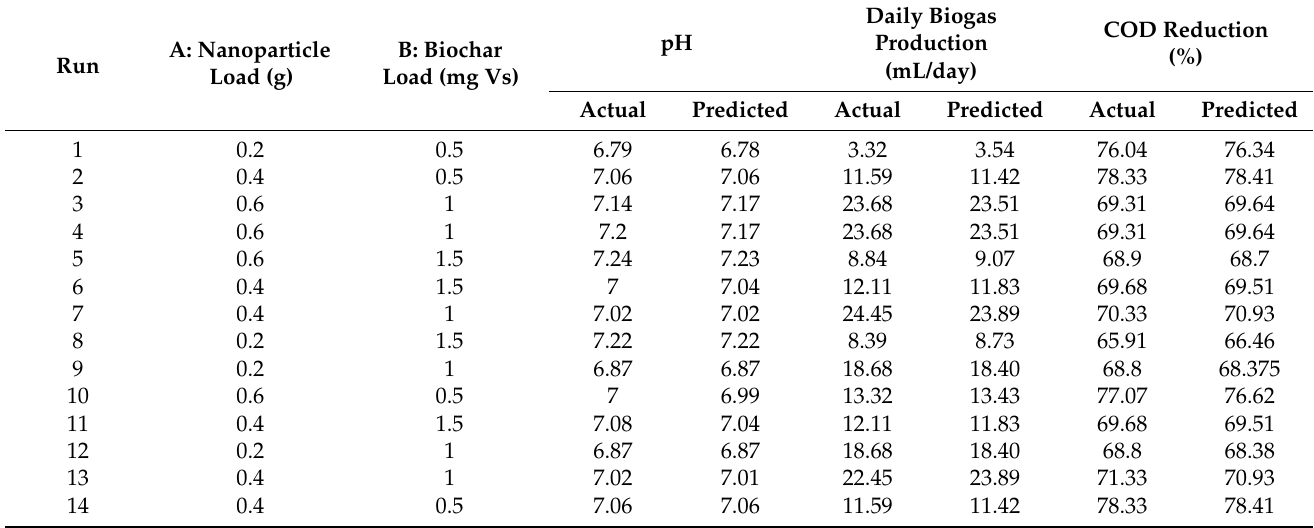
Table 1. Central composite design matrix with experimental and predicted